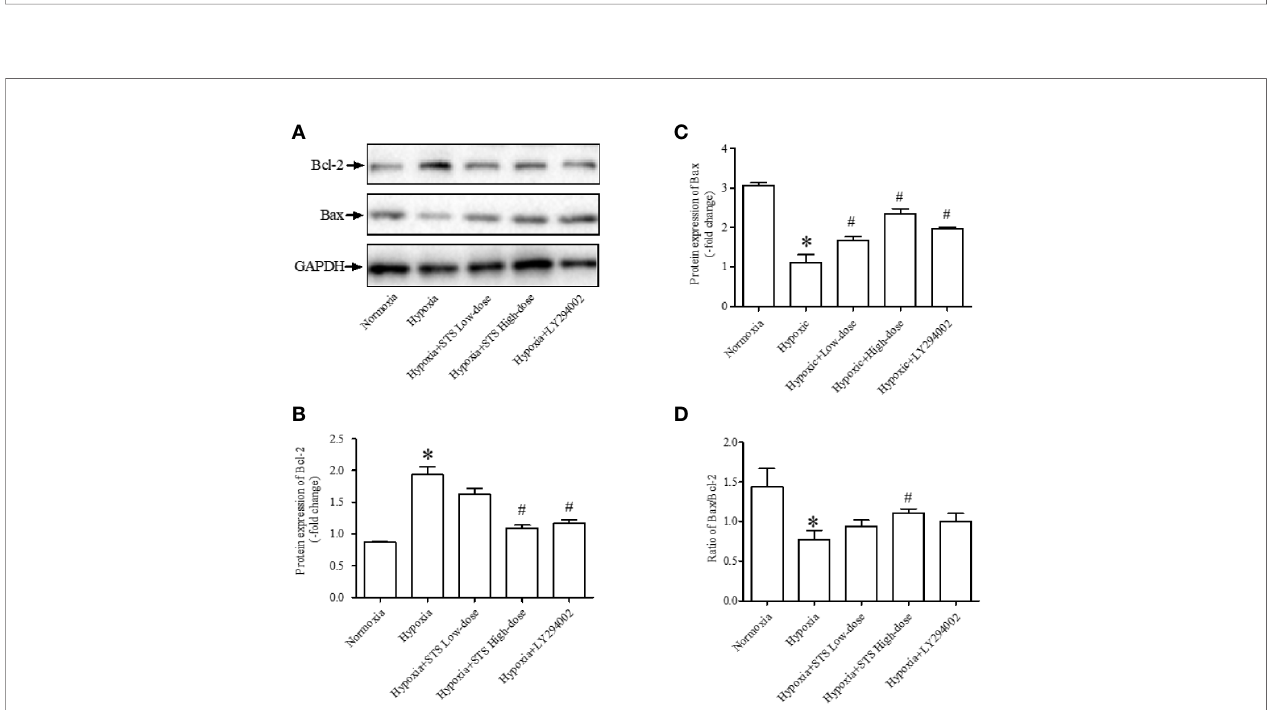
FIGURE 5 | Expression of anti-apoptotic and pro-apoptotic proteins. (A) Representative blots of Bcl-2 and Bax proteins, GAPDH acted as the internal reference; (B) densitometry analysis of Bcl-2 expression in each group; (C) densitometry analysis of Bax expression in each group; (D) densitometry analysis of the ratio of Bax to Bcl-2 in each group. Each bar presents the Mean ± SEM, n = 5 – 8. * P < 0.05 compared with normoxia group, # P < 0.05, compared with hypoxia group.